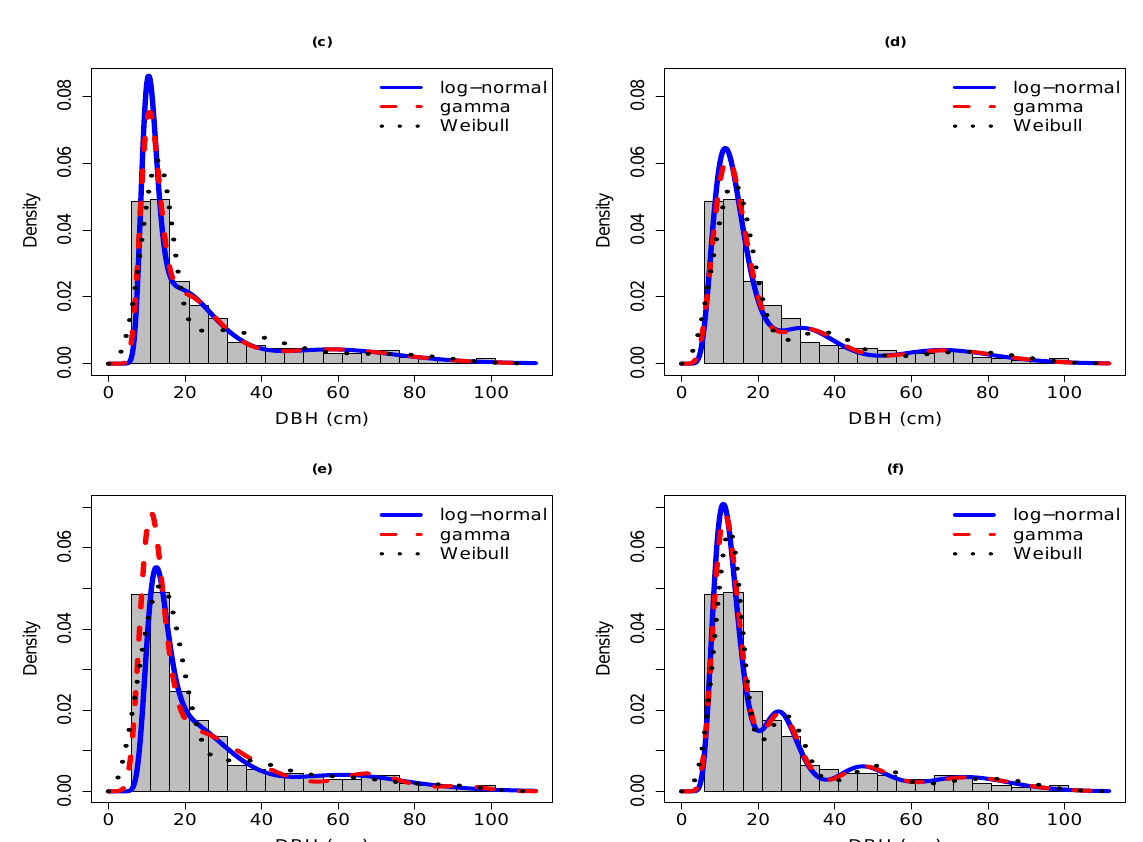
Figure A4. Histograms of DBH data in sample 3 corresponding to classes of width 5 cm. Superimposed in each subfigure are estimated pdf of the mixture of Weibull (solid line), gamma (dashed line), and log-normal (dotted line) distributions. The fitted pdf in subfigures are related to: ( a ) 2-component mixture models fitted to grouped data, ( b ) 2-component mixture models fitted to ungrouped data, ( c ) 3-component mixture models fitted to grouped data, ( d ) 3-component mixture models fitted to ungrouped data, ( e ) 4-component mixture models fitted to grouped data, and ( f ) 4-component mixture models fitted to ungrouped data.